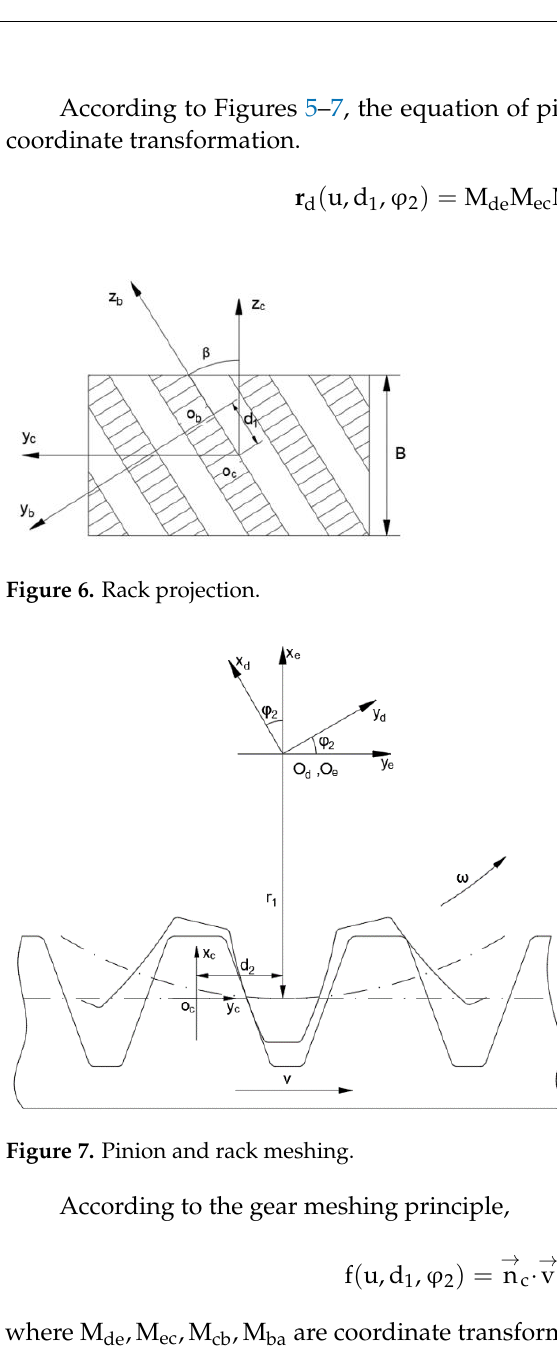
9 of 21 Figure 5. Normal tooth profile of rack cutter. According to Figures 5 – 7, the equation of pinion tooth surface can be obtained by coordinate transformation. 𝐫 d (u, d 1 , φ 2 ) = M de M ec M cb M ba 𝐫 a (u) (25) According to the gear meshing principle, f(u, d 1 , φ 2 ) = n⃗ c ∙ v⃗ c(c,d) = 0